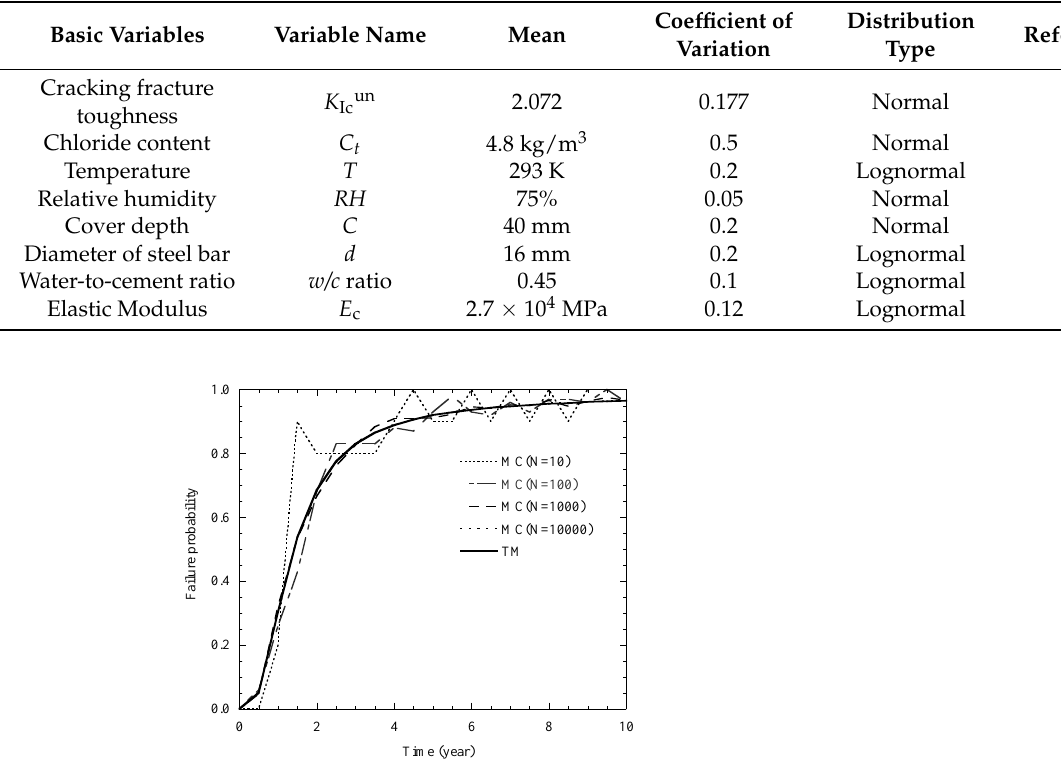
Table 7. The parameter values used in model verification of rust expansion cracking time.